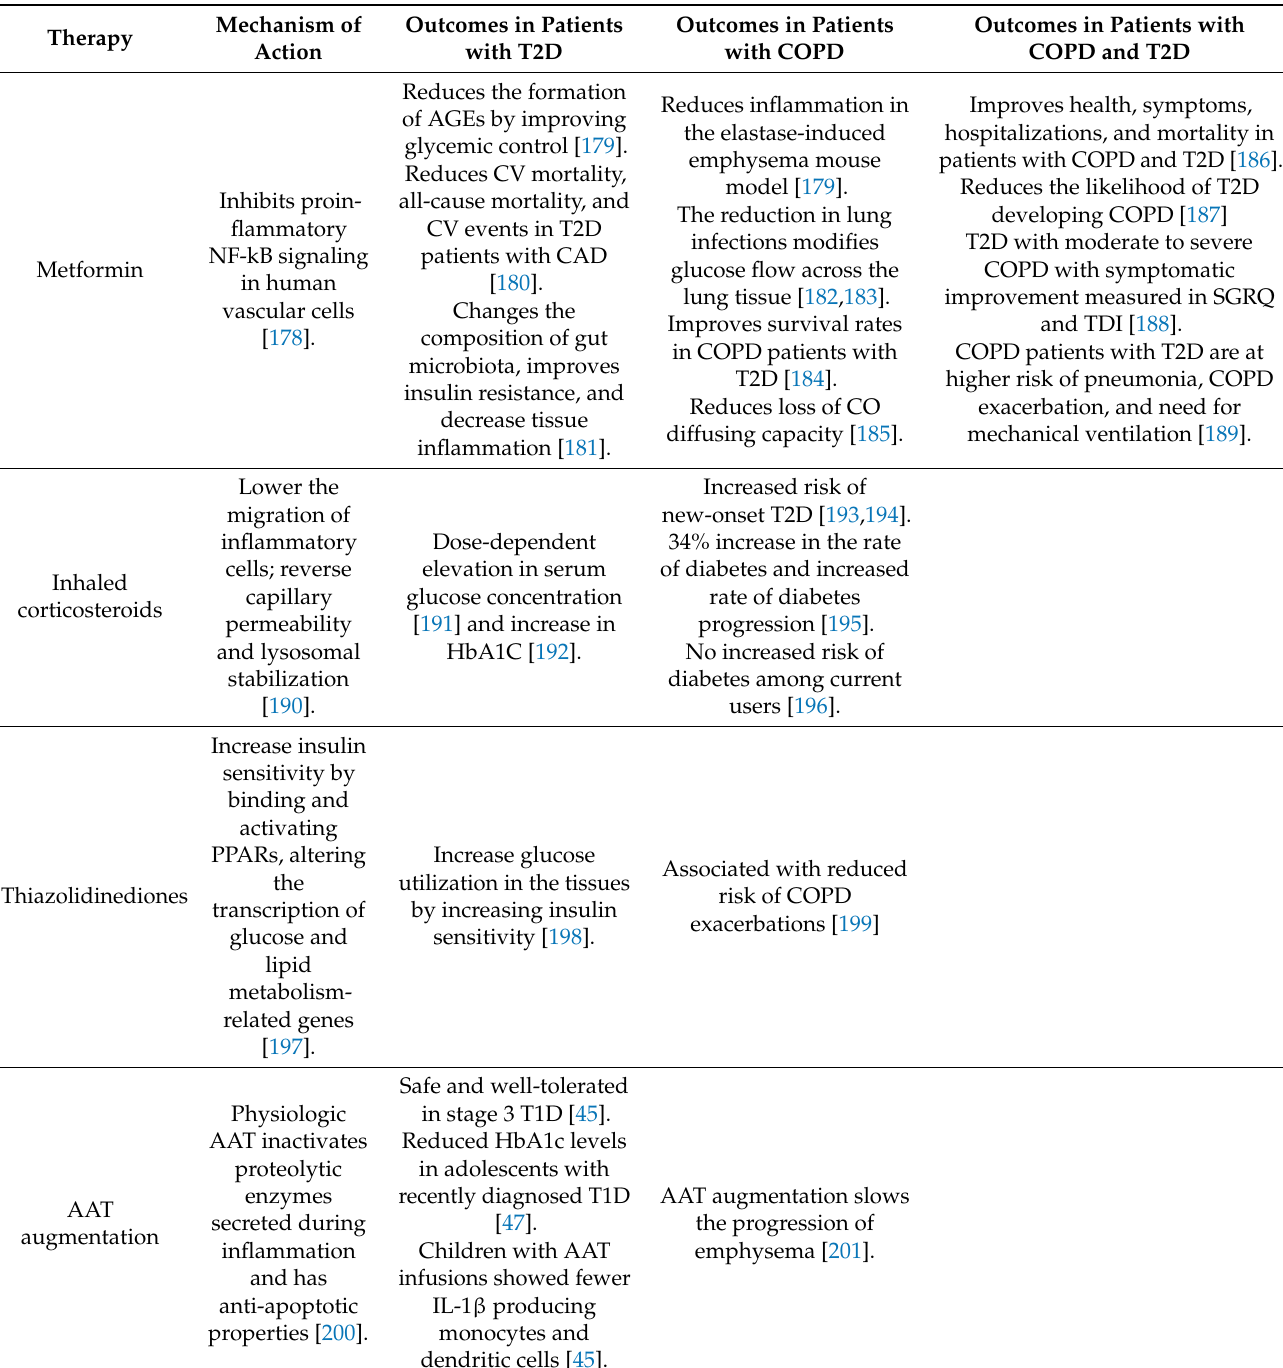
Table 1. Summary of therapeutic strategies for COPD and